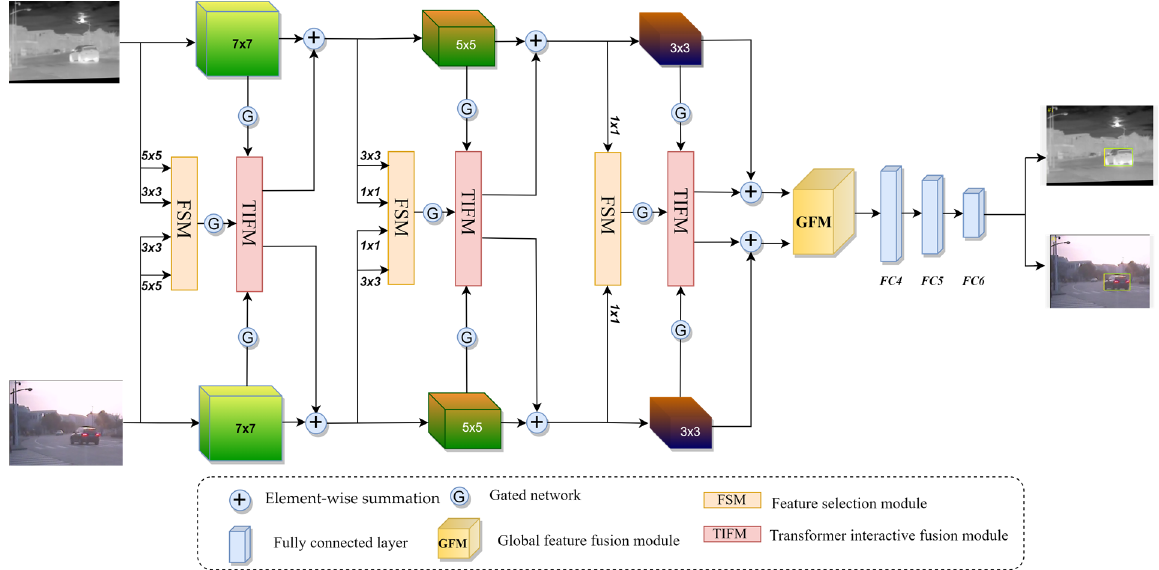
Figure 2. The overview of the proposed MSIFNet framework.